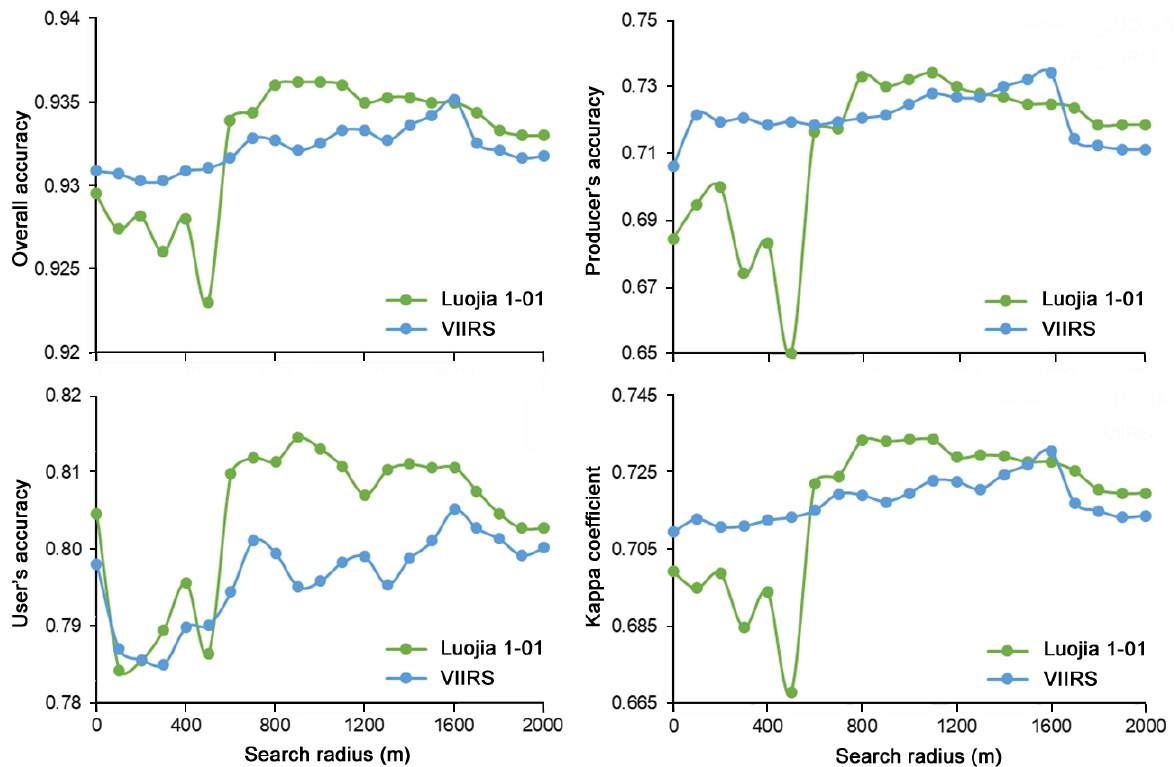
Figure 6. The change of accuracy evaluationmetrics for built-up area extractions under different search radii using Luojia 1-01 and VIIRS data products.The evaluation values at the search radius of 0 m represent the raw data of LuoJia 1-01 and VIIRS, respectively, without application of KDE. Table 1. Confusion matrix of extracting built-up area with different search radii using Luojia 1-01 and VIIRS data prod- ucts. BA: built-up areas; NA: non-built-up areas.